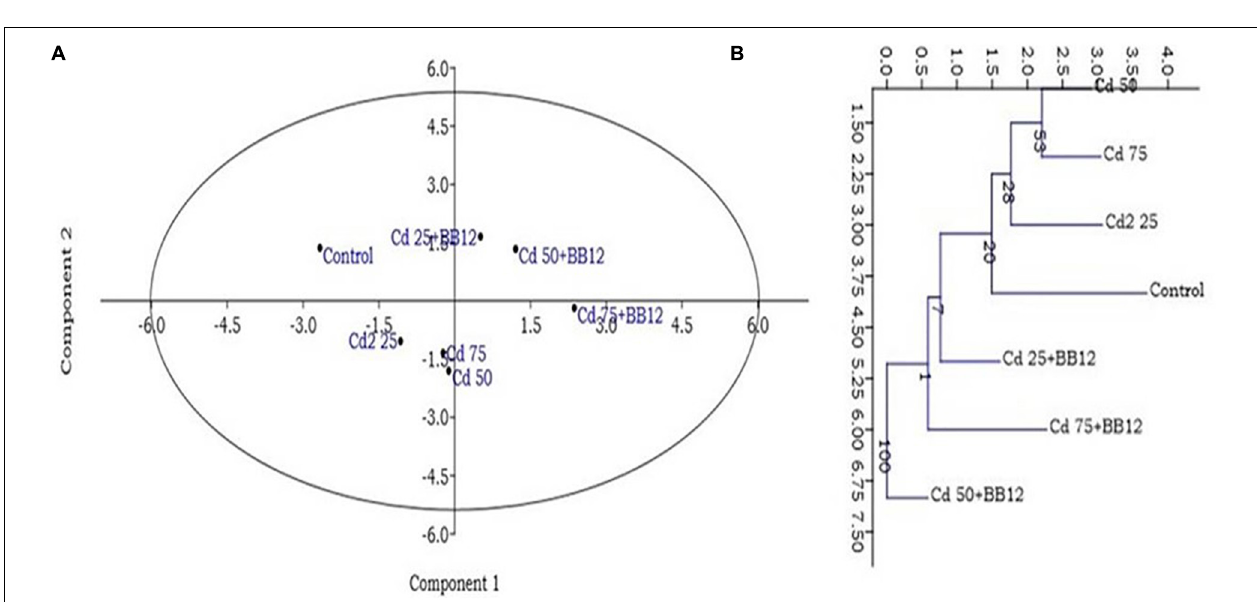
FIGURE 7 | Principal component analysis (PCA) (A) and clustering analysis (B) showing the impact of 25, 50, and 75 mg kg − 1 Cd concentration on the spinach plants grown in the soil containing Cd as compared to normal soils with no Cd concentration. Mean of PCA-axis values ± SD ( n = 3, p < 0.05).